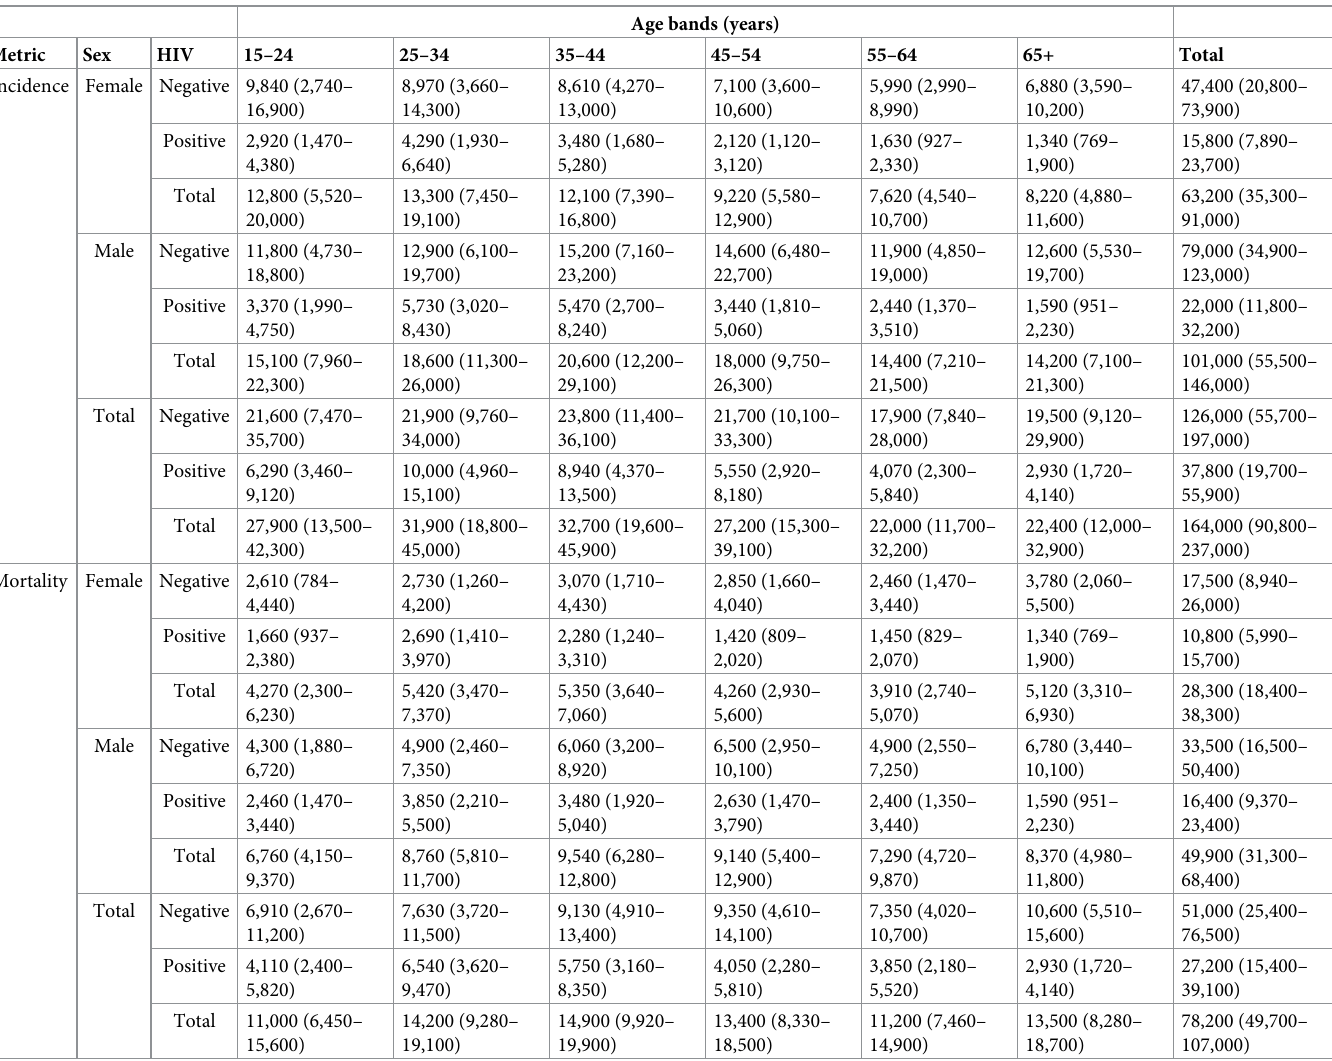
Table 3. Incidence and mortality of tuberculous meningitis, stratified by age band, HIV status and